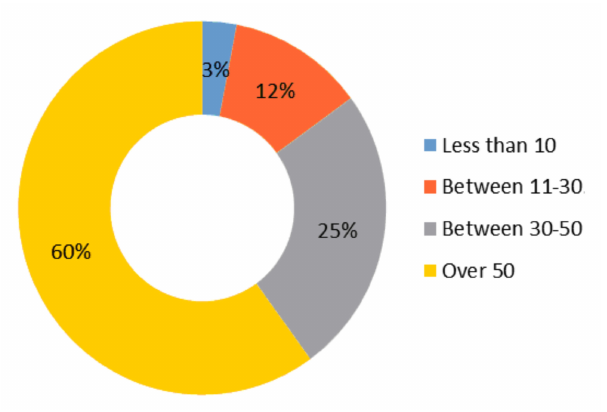
Figure 4. About how many books can you find at